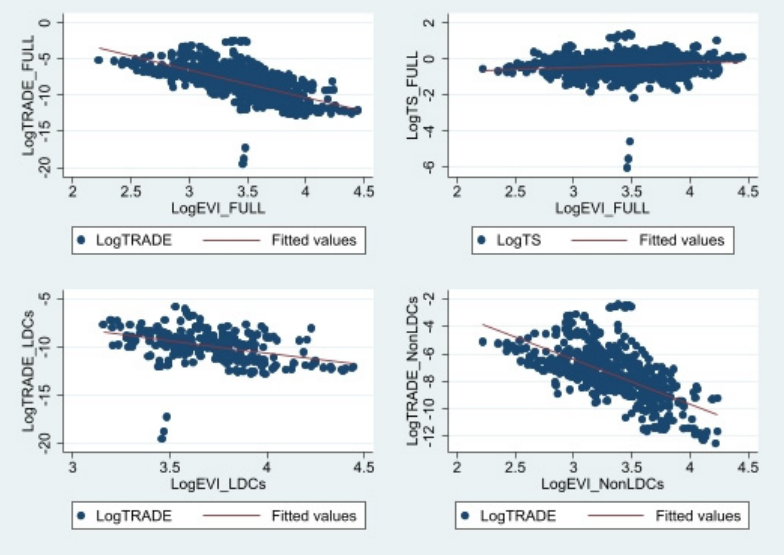
Figure 3. Correlation between EVI and participation in international trade over the full sample. Source: Author. Note: “FULL” means full